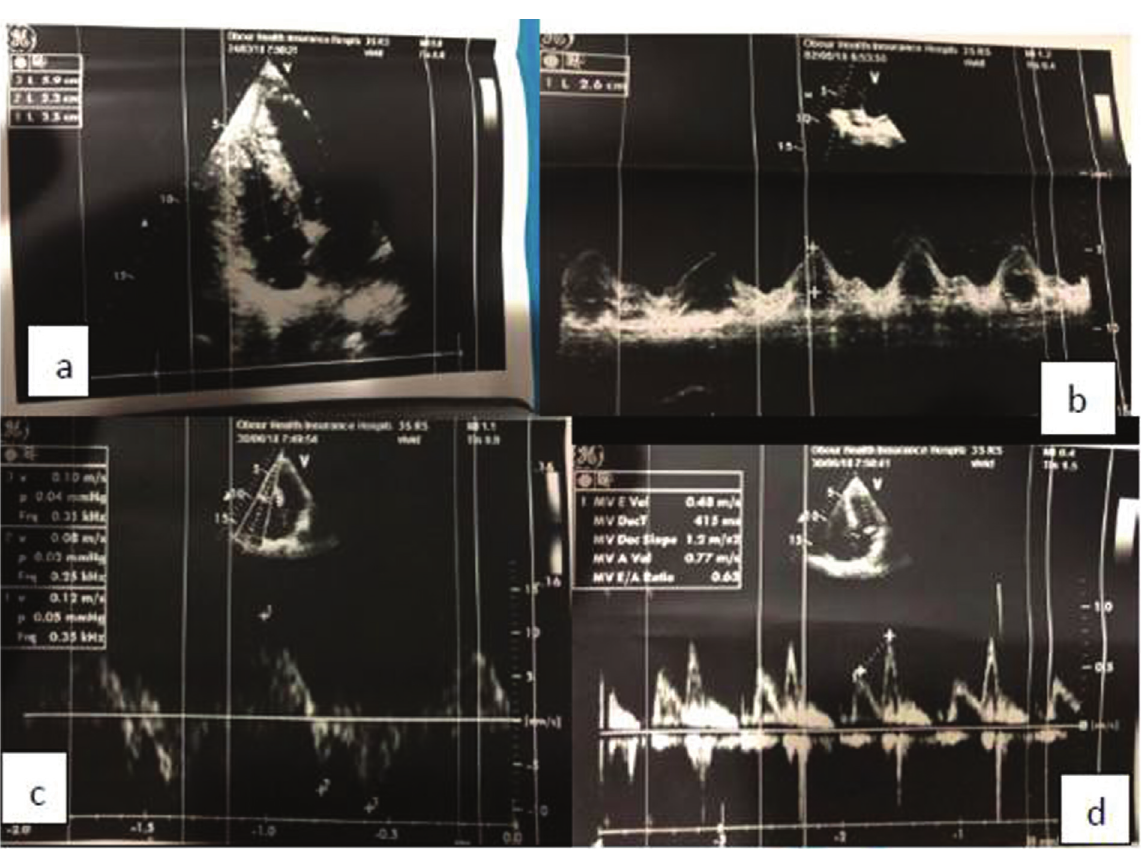
(a) Linear dimensions of right ventricle: basal diameter, mid cavity, and longitudinal. (b) TAPSE by applying M-mode at the lateral free wall of RV. (c) Myocardium velocities by TDI at the lateral tricuspid annulus: 1 → S ’ , 2 → E ’ . (d) Transmitral flow parameters: E, A, and E/A. RV, right ventricular; TAPSE, tricuspid annular plane excursion; TDI, tissue Doppler